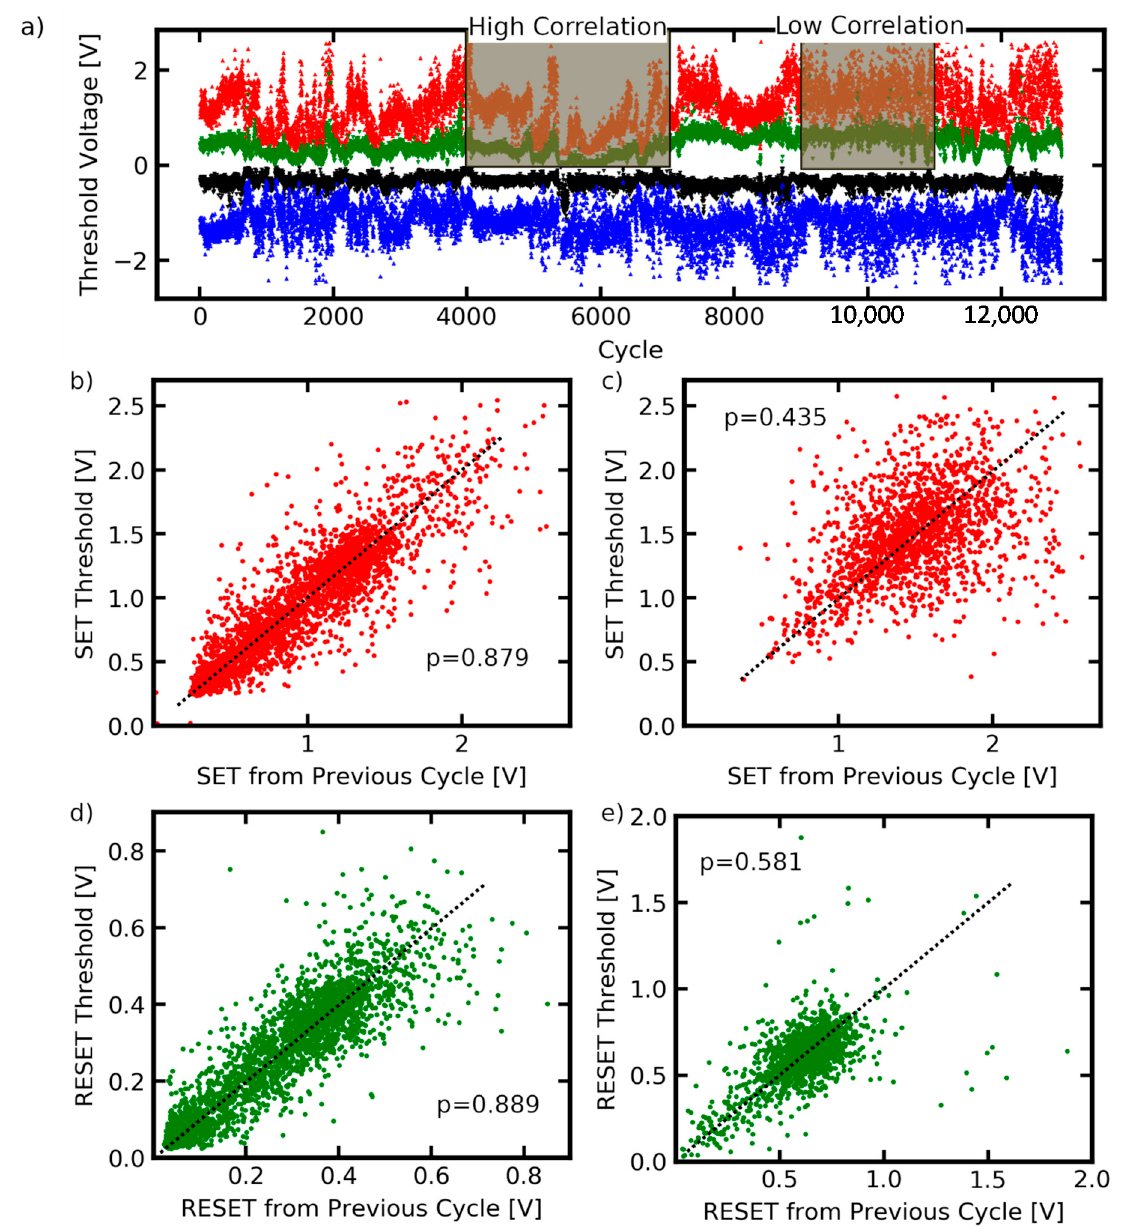
Figure 3. ( a ) All threshold voltages extracted from the long-term measurement ranging over 12,000 cycles of one memtip sample and plotted against the cycle number. In the indicated high correlation regime (cycles 4000 to 7000) the threshold voltages show a significant dependence on the former values from the previous cycles, resulting in pronounced trends in threshold voltage evolution over several cycles. In a later regime (cycles 9000 to 11,000), which suggests a low correlation, the individual threshold voltages are more independent from each other, and no pronounced trends are observable. The Pearson coefficient quantifies the linear correlation between the individual threshold voltages and the respective former value from the cycle before, for the SET and RESET events in the high correlation regime, ( b ) and ( d ), respectively, and the low correlation regime, ( c ) and ( e ), respectively.